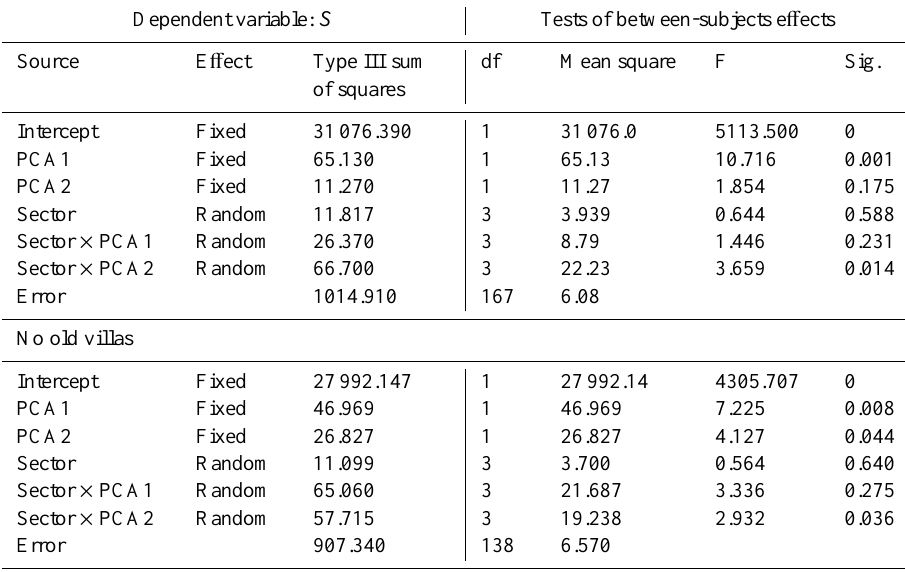
Table 4. Analysis of co-variance (GLM) of the e ff ects of two fixed factors (PCA factor sores) and one random factor (sectors) on the number of bird species ( S ) recorded at each point count station. The models were performed by using all the point count stations (above) and then repeated without considering the green areas belonging to the old villas